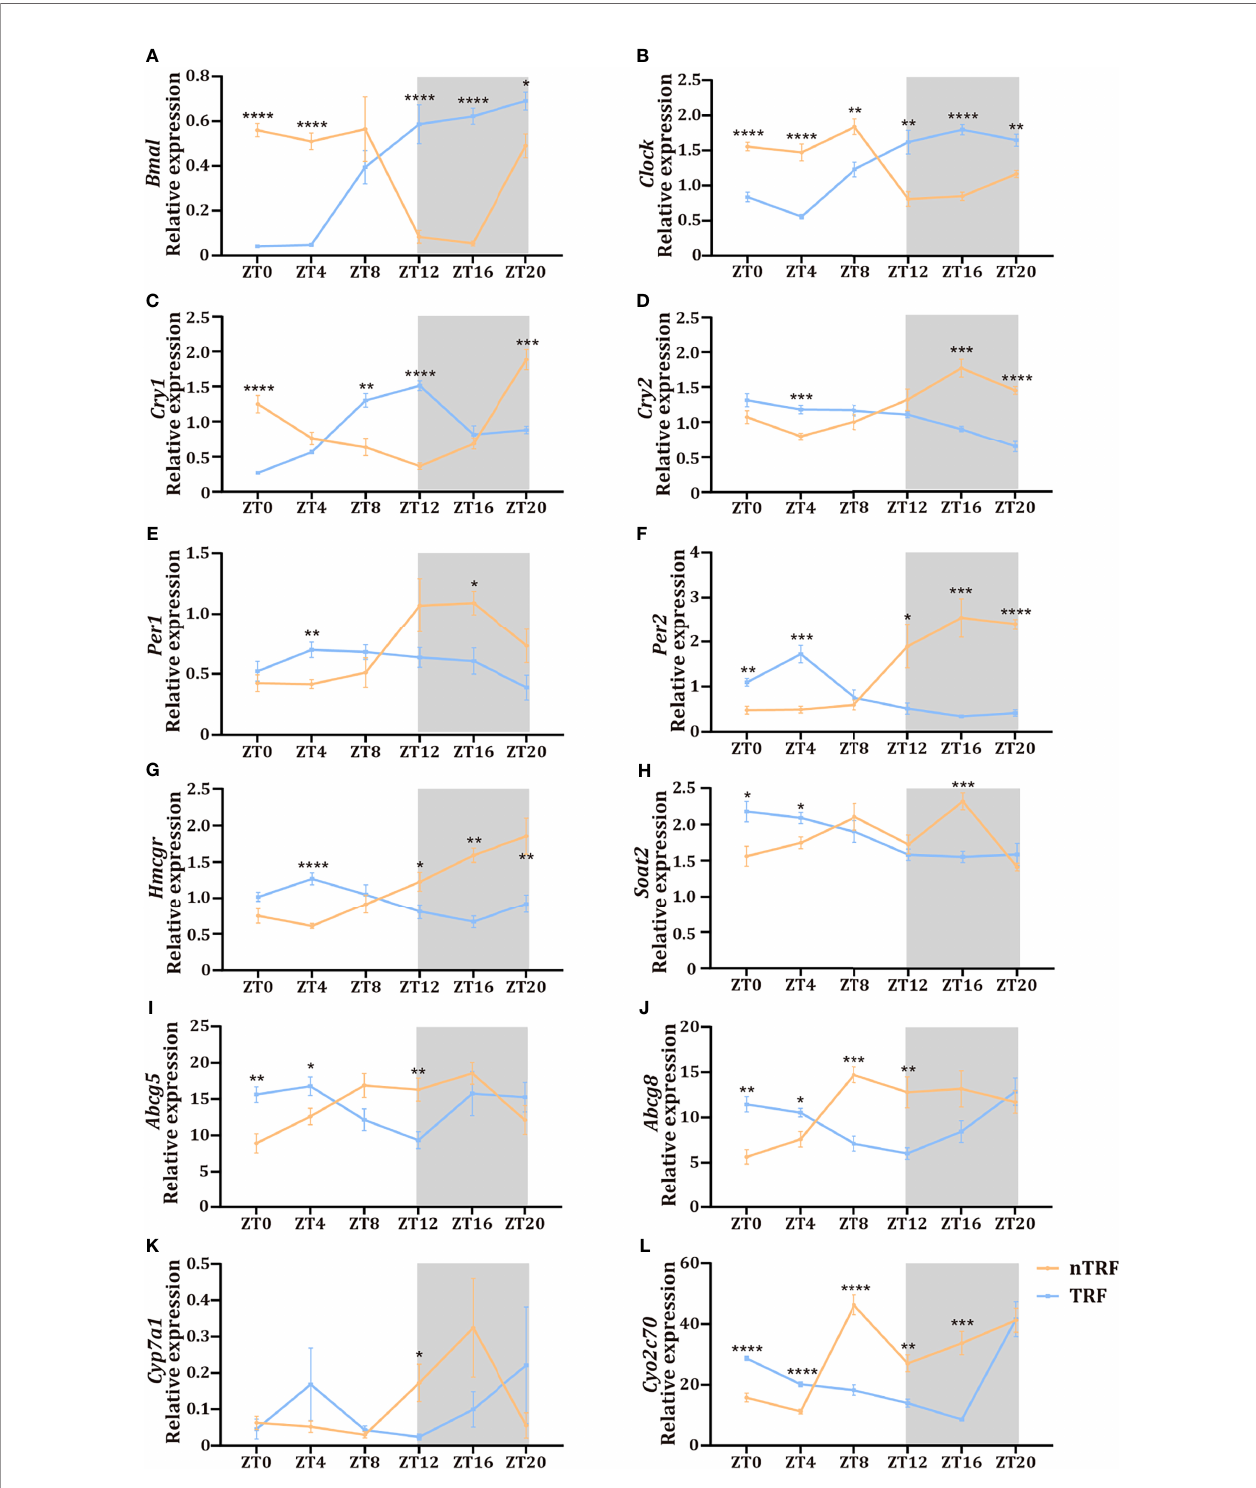
FIGURE 3 | Time-restricted lithogenic diet-feeding (TRF) disrupts the expression patterns of hepatic genes. (A – F) Expression of hepatic central clock genes at various ZT. (G – L) Expression of genes involved in cholesterol and bile acid metabolism at various ZT. Data are expressed as mean ± SEM (n = 5 mice/group at each time point). “ * ” means p < 0.05, “ ** ” means p < 0.01, “ *** ” means p < 0.001, “ **** ” means p <